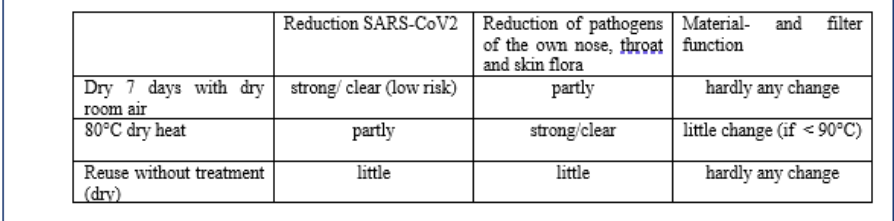
Figure A3. Scientific Posting Team D. Note. Predictor media content: scientific Posting Team D. Orig-